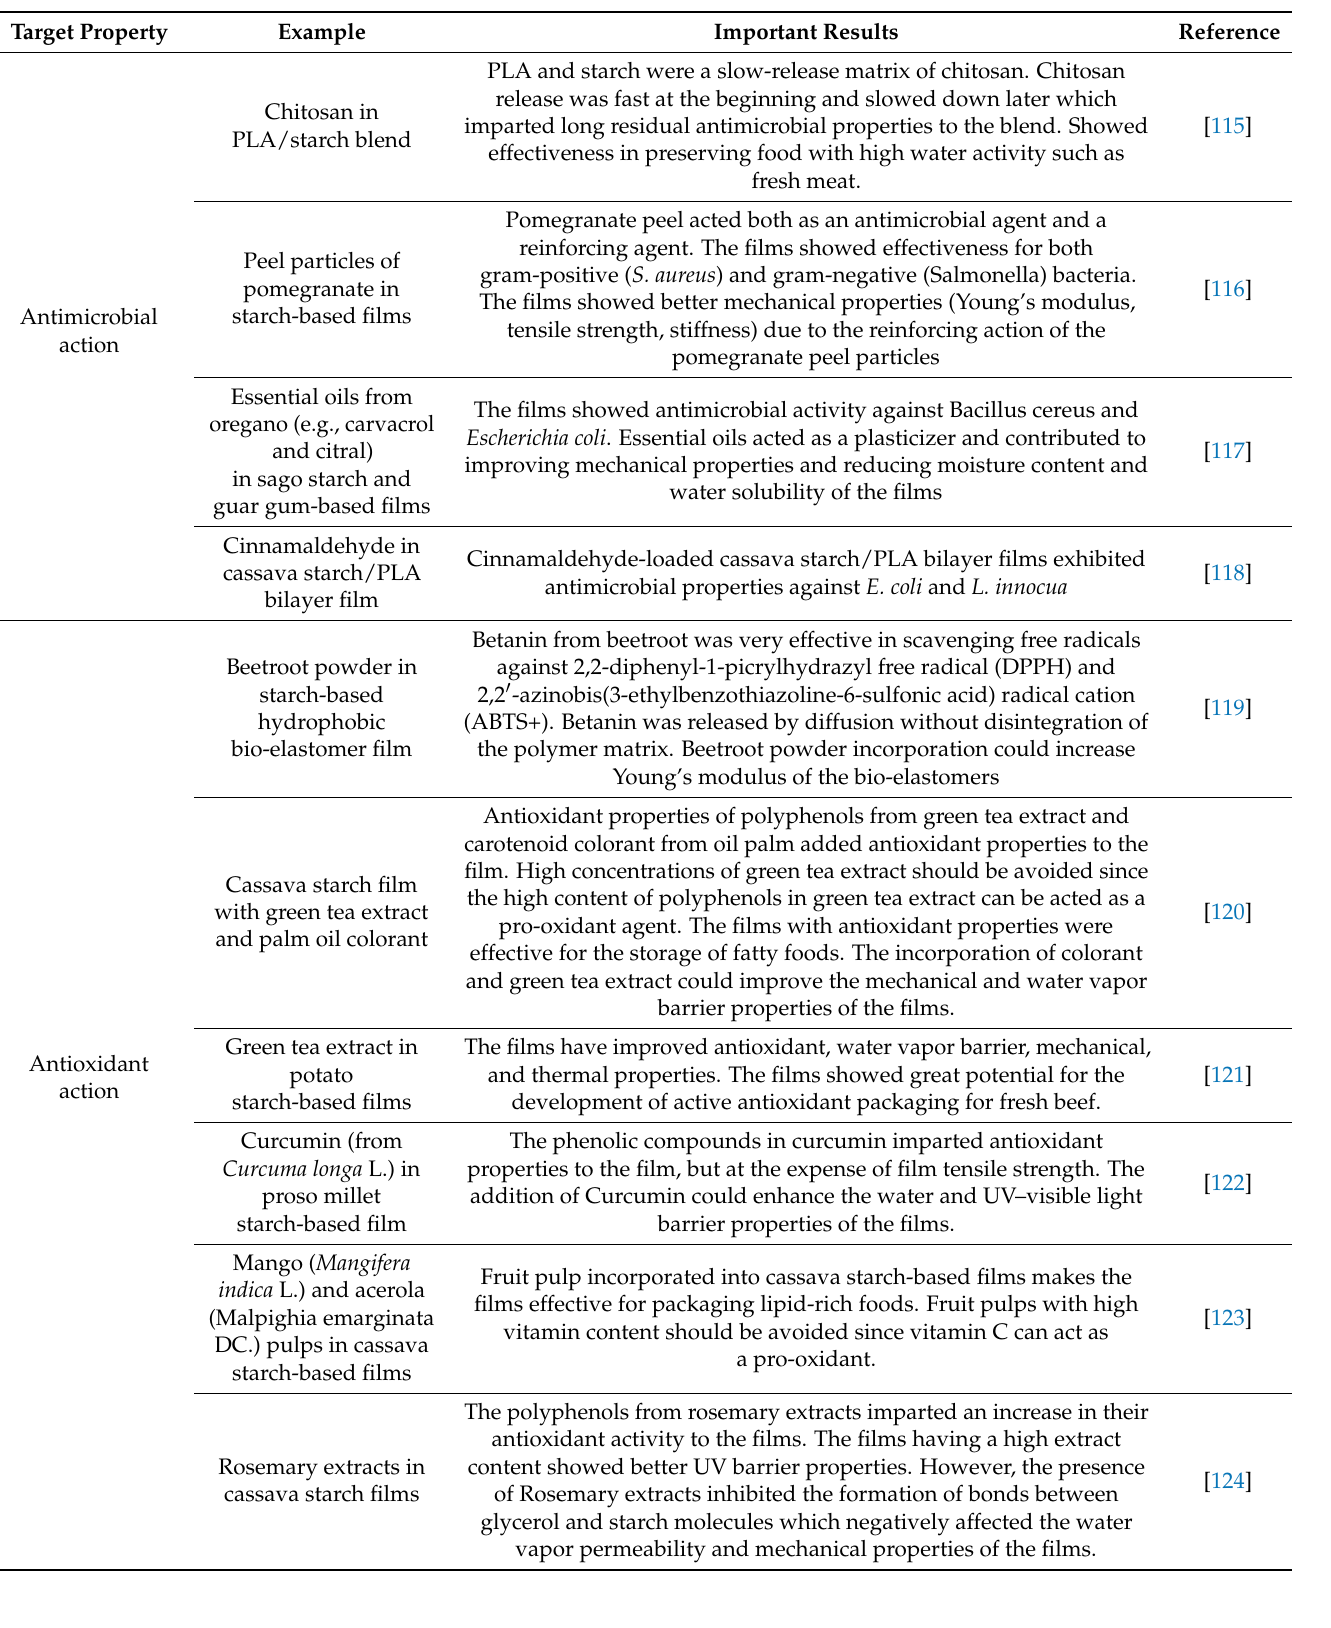
Table 2. Examples of different types of functionalized starch-based